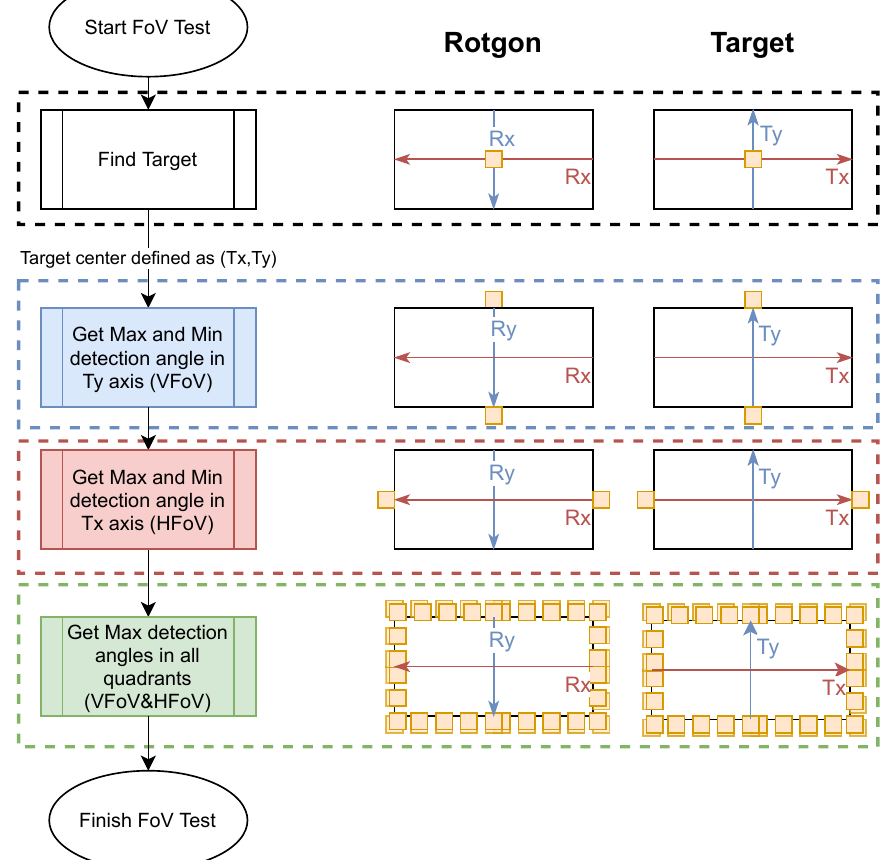
Figure 11. Field of view flowchart